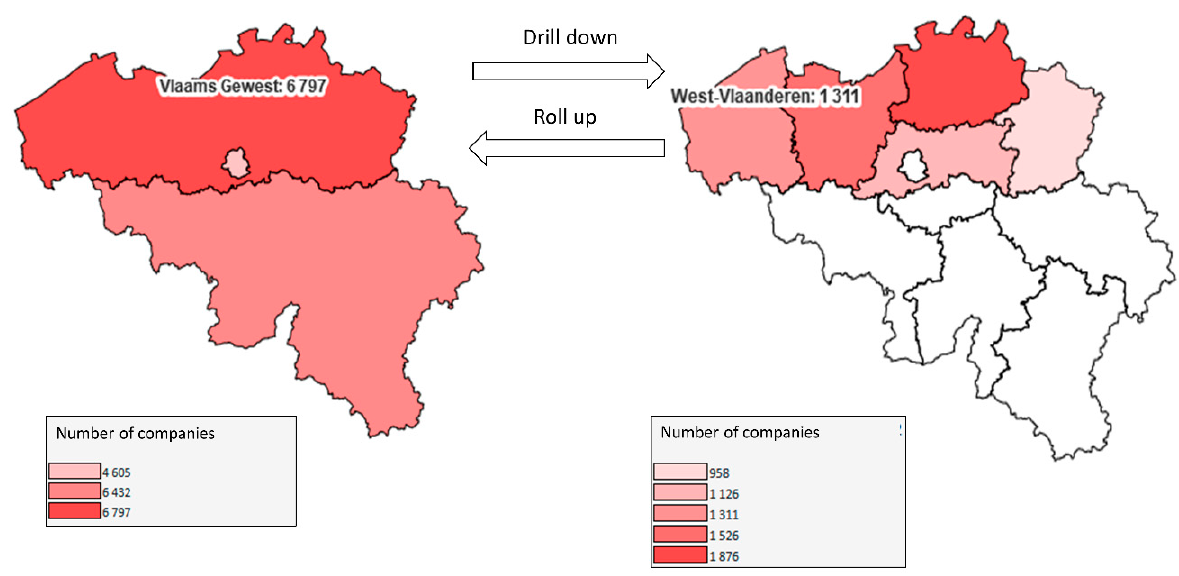
Figure 8. “Drill down” and “roll up” example on a geographic dimension (map interface).